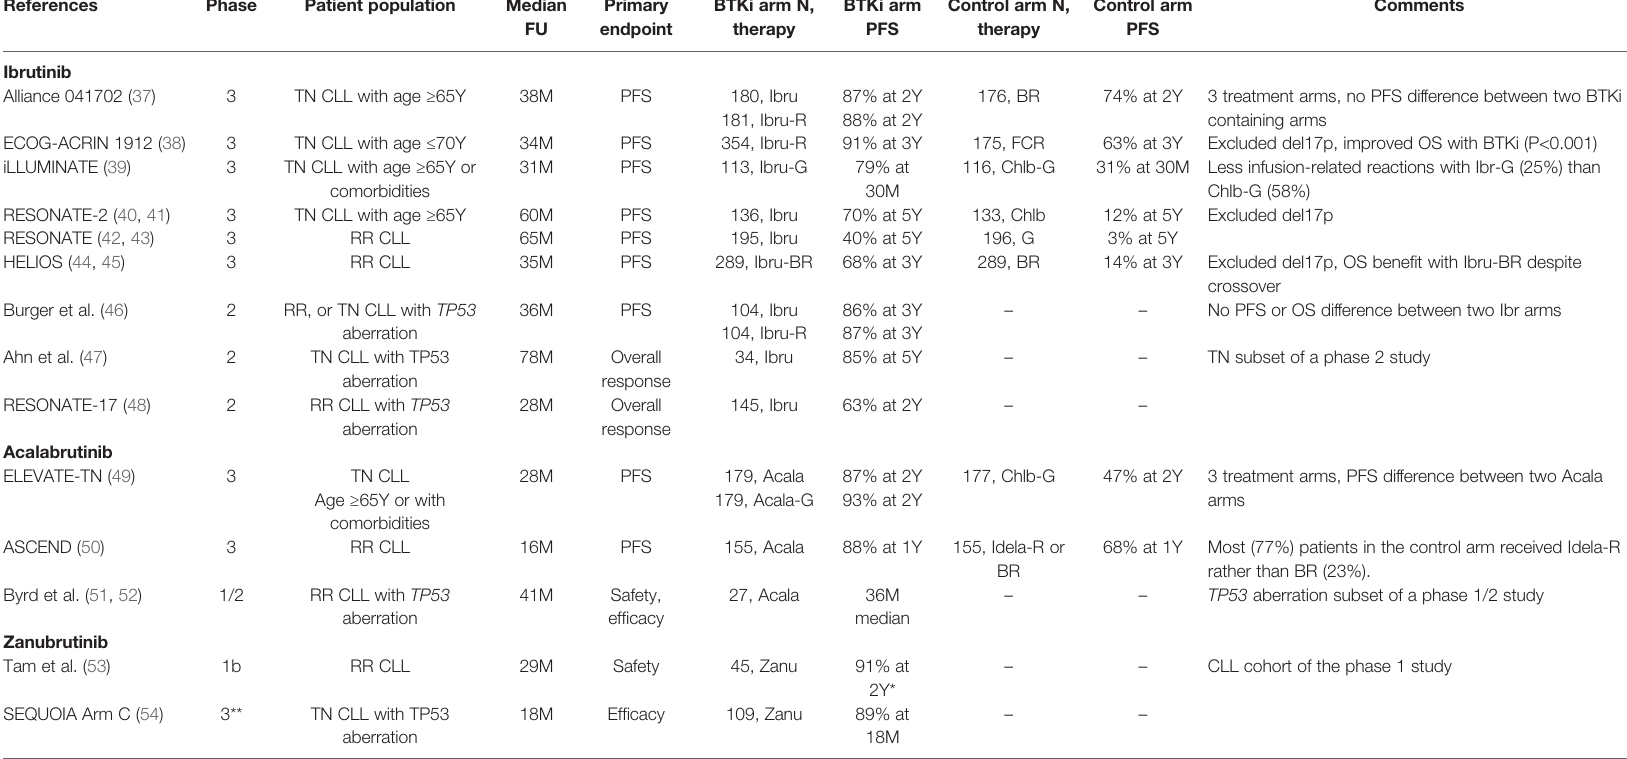
TABLE 2 | Selected clinical trials testing covalent BTK inhibitors in